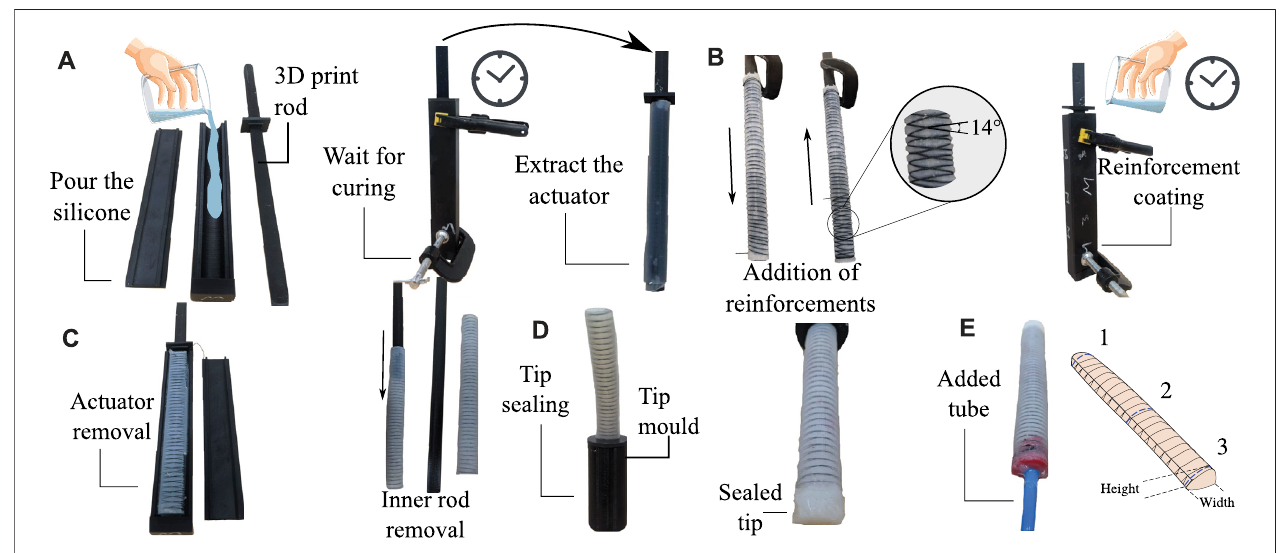
FIGURE 2 | The construction process of an FR type silicone actuator. (A) First stage: pouring the silicone into the internal mould, pressing the mould to avoid leakage during curing and removing the actuator after silicone curing. (B) Second stage: addition of reinforcements for bending movement. Initially, a double spiral is woven, and the inelastic layer is glued to the bottom of the actuator. The reinforcements should be coated with silicone through the external mould. (C) Third stage: removal of the actuator from the inner rod. (D) Fourth stage: Sealing off the ends. (E) Fifth stage: Placement of the plastic tube to in fl ate the actuator.